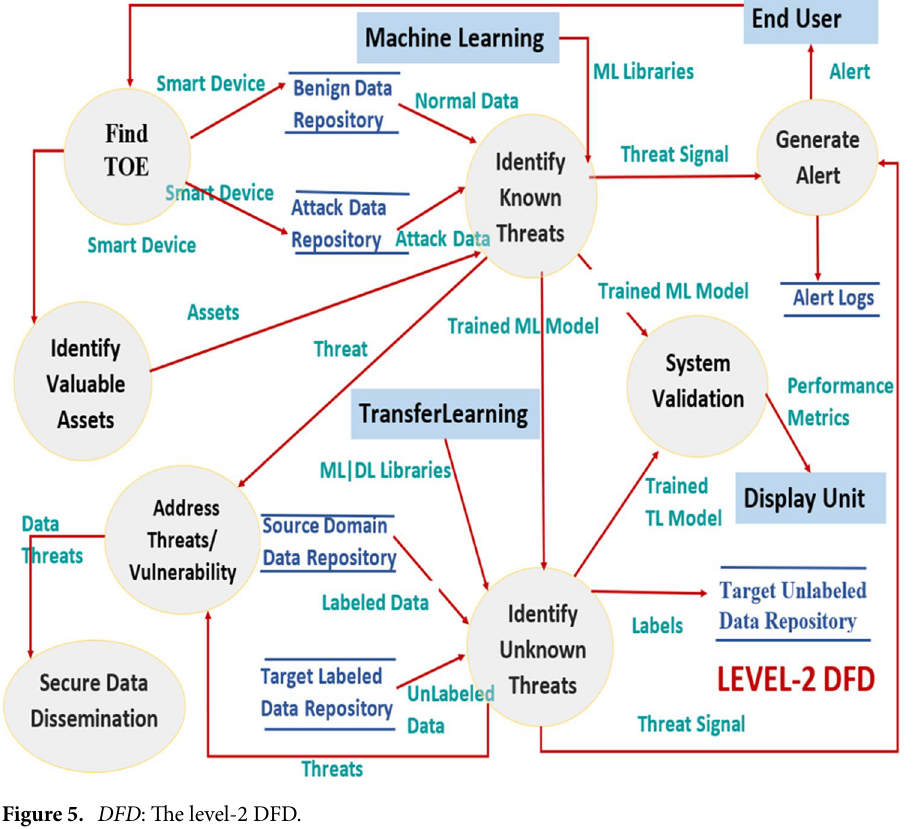
Figure 5. DFD : The level-2 DFD.